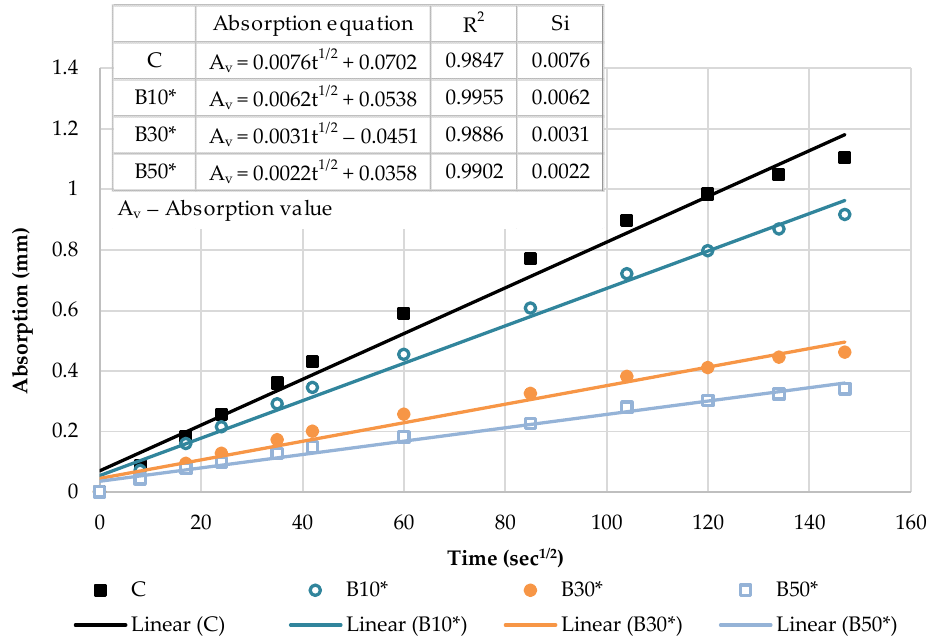
Figure 19. The initial capillary absorptivity of biomass ash–based mortars with decreased w/b.